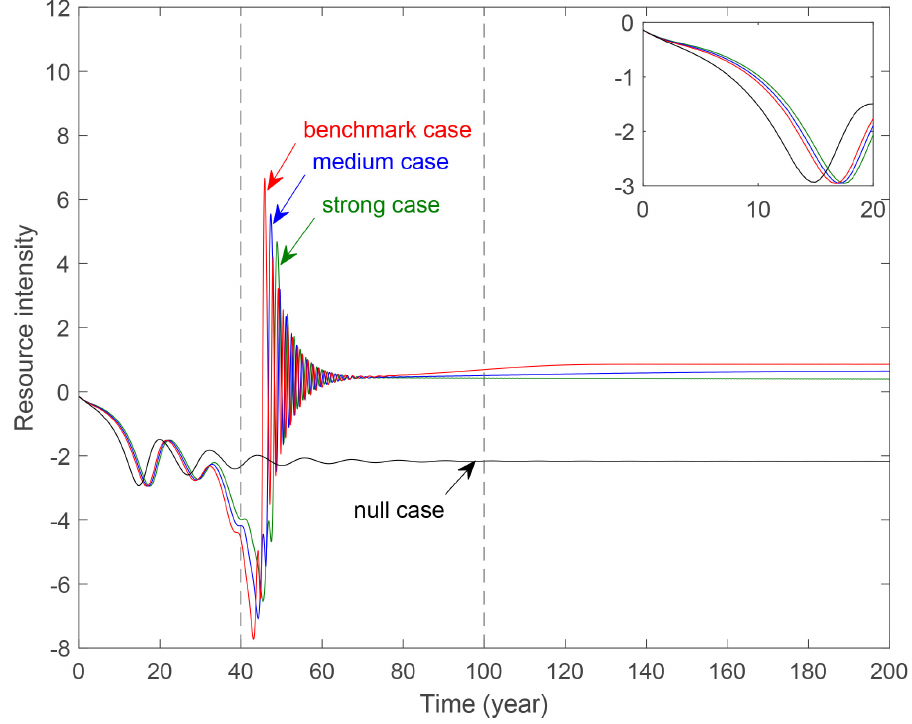
Fig 12. Evolution of resource intensity with different technology level parameter a 4 . Benchmark case : a 4 = 0.0008. Medium case : a 4 = 0.0208. Strong case : a 4 = 0.0408.